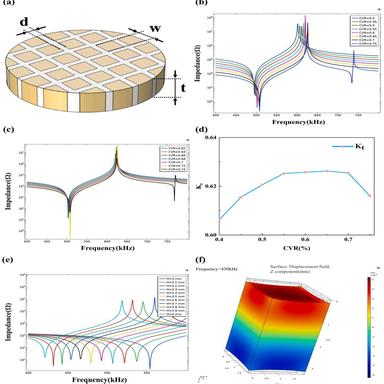
Finite element simulation results of the 1–3 piezoelectric composites (a) Schematic diagram and (b) Impedance spectrum of 1–3 piezoelectric composites with different ceramic volume ratios (CVR) (0.4, 0.45, 0.5, 0.55, 0.6, 0.65, 0.7, 0.75) and (c) CVR (0.62, 0.64, 0.66, 0.68, 0.70, 0.72, 0.74) and (d) Electromechanical coupling coefficient Kt of the 1–3 piezoelectric composite with different CVR (e) Impedance spectrum of 1–3 piezoelectric composites with different ceramic pillar heights and (f)Thickness vibr